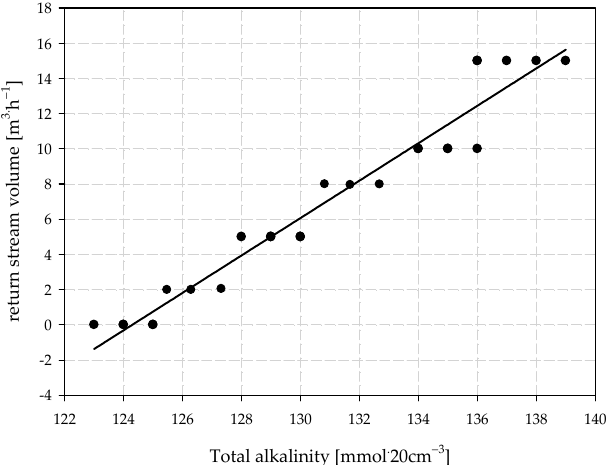
Figure 1. Effect of return stream volume on total alkalinity of AAB.